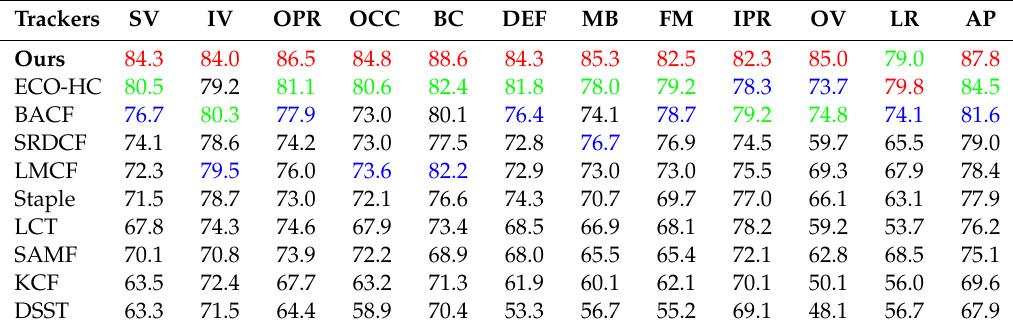
Figure 6. Experimental results for the representative ten trackers represented by ten different color curves: ( a ) The PP of the OPE on all sequences; ( b ) The SP of the OPE on all sequence. Table 3. Central position accuracy and average accuracy of representative ten trackers in 11 different attributes. Red, green, and blue, respectively, represent the top three trackers. Trackers